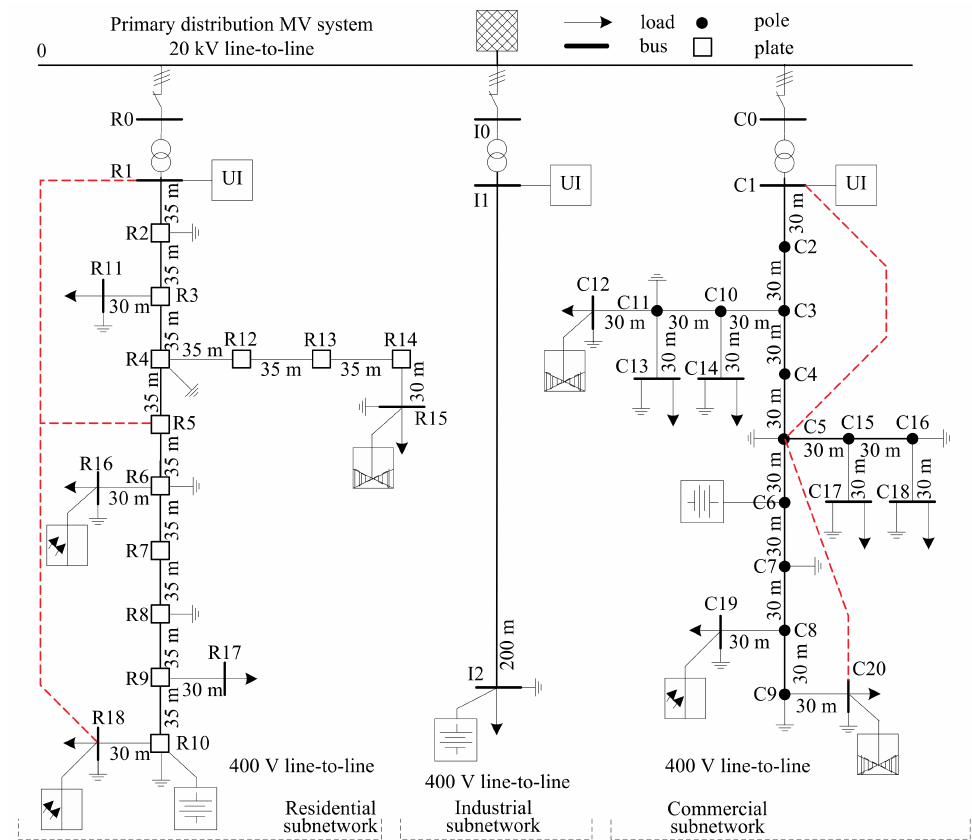
Figure 4. CIGRE European low-voltage network considered as application